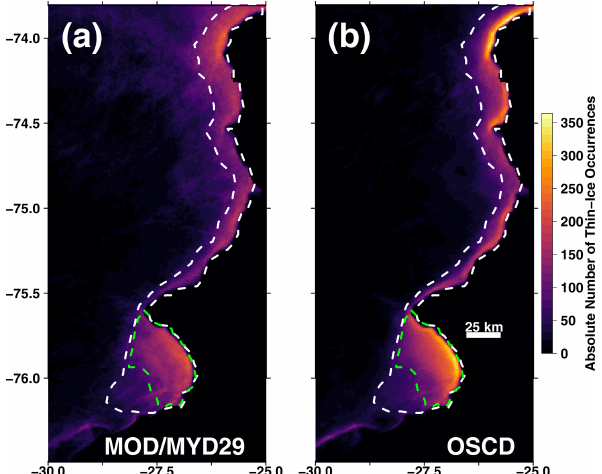
Figure 9. Comparison of per-pixel thin-ice occurrence based on all available swaths from 1 April to 30 September 2017 between the use of MOD/MYD29 (a) and OSCD data (b) , respectively. White and green dashed lines mark the core BIS region as well as the primary BIS polynya area, respectively, used for further analyses.